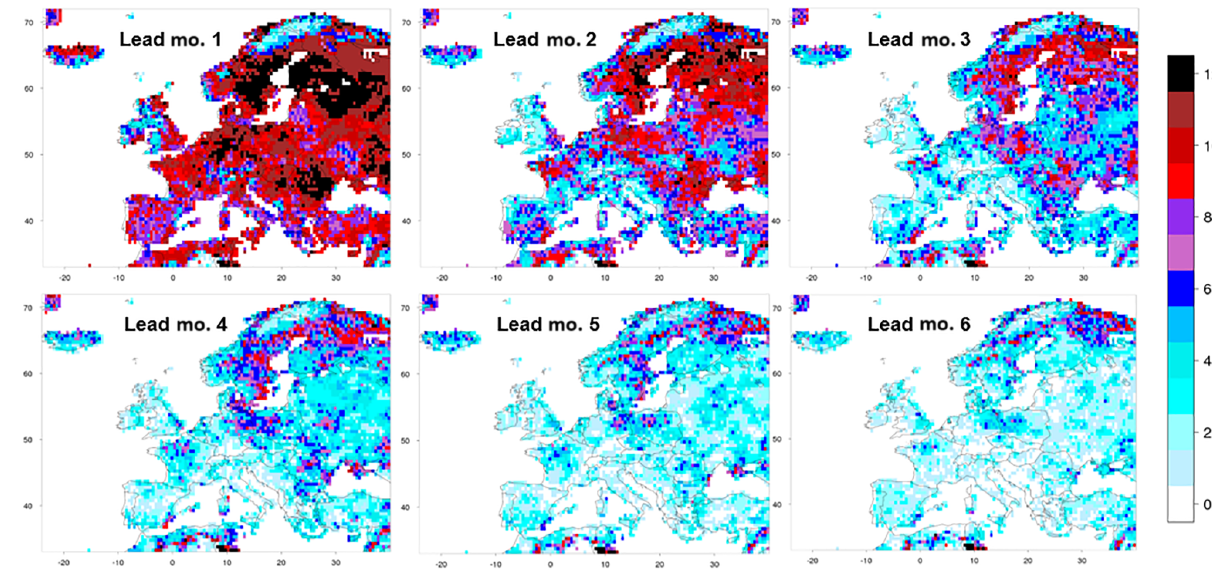
Figure 4. Number of months in a year with significant skill ( R ) in the run-off forecasts of lead months 1–6.